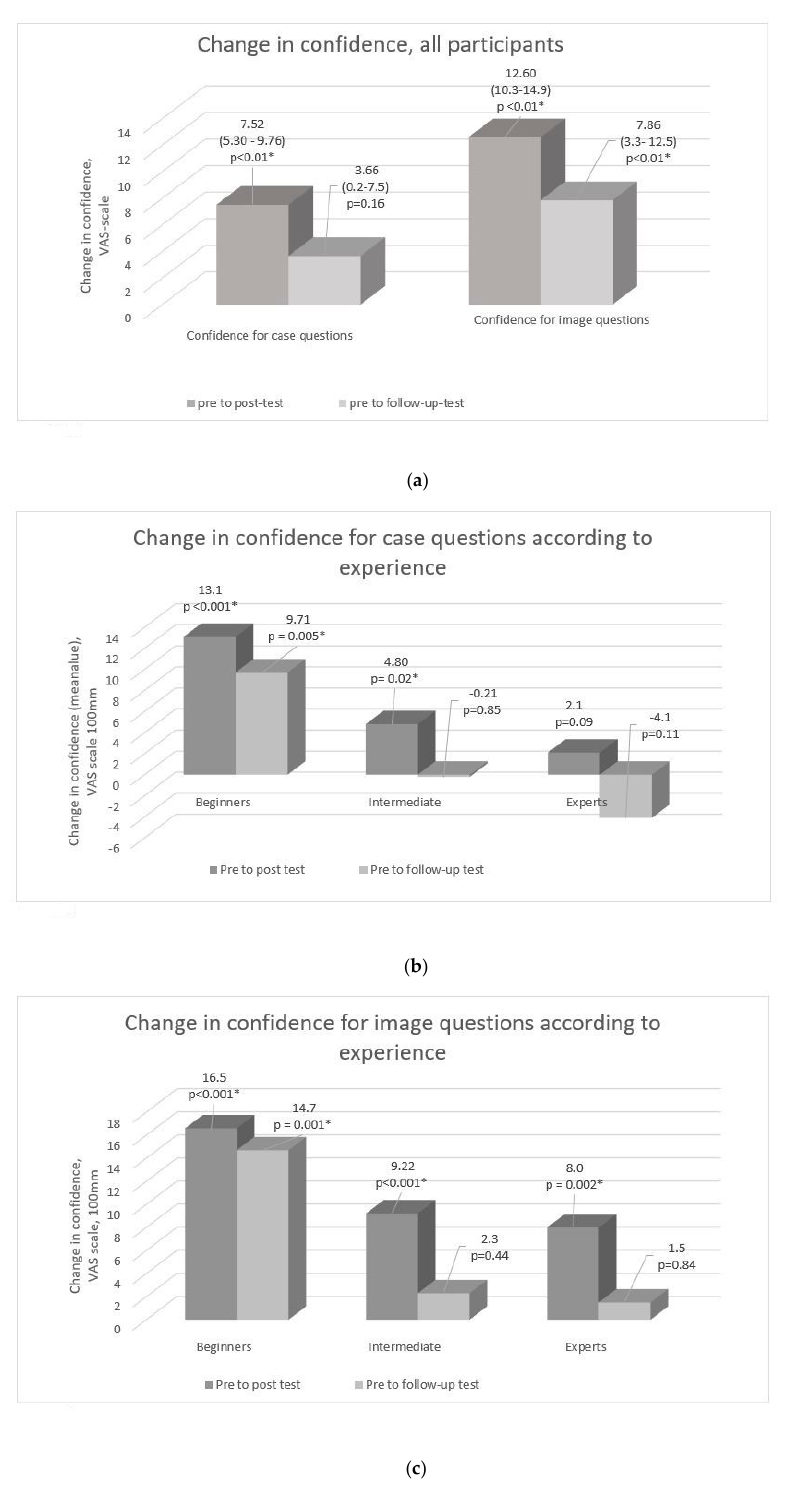
Figure 3. Results stratified by experience. Change in mean values for confidence (0 = not at all confident, 100 = very confident) in all questions ( a ) and separately for case questions ( b ) and image questions ( c ) according to experience. p -Value is presented with * if the change is statistically significant.